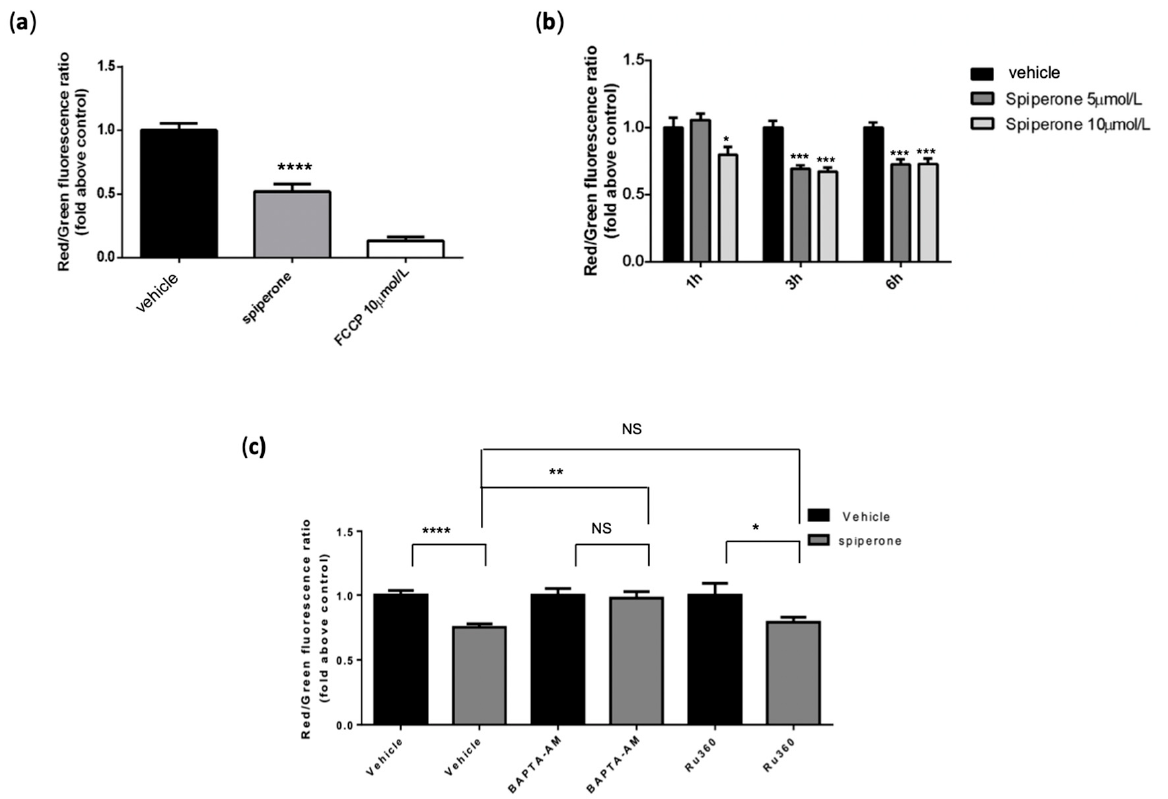
Figure 10. Spiperone induces mitochondrial damage. Mitochondrial membrane potential depolarization was evaluated by JC-1 staining after 1, 3, 6 ( b ), and 16 h ( a ) treatment with 5 and 10 μ mol/L spiperone, alone or in combination with 10 μ mol/L BAPTA-AM and 10 μ mol/L of the MCU inhibitor Ru360 in HCT116 cells ( c ). Pictures were acquired via fluorescence microscopy. Histogram showing quantification of the red/green fluorescence ratio as fold change relative to controls. Data are presented as the mean ± SD from three independent experiments, each performed in triplicate. *: Student’s t -test p < 0.05; **: Student’s t -test p < 0.01; ***: Student’s t -test p < 0.001; ****: Student’s t -test p <